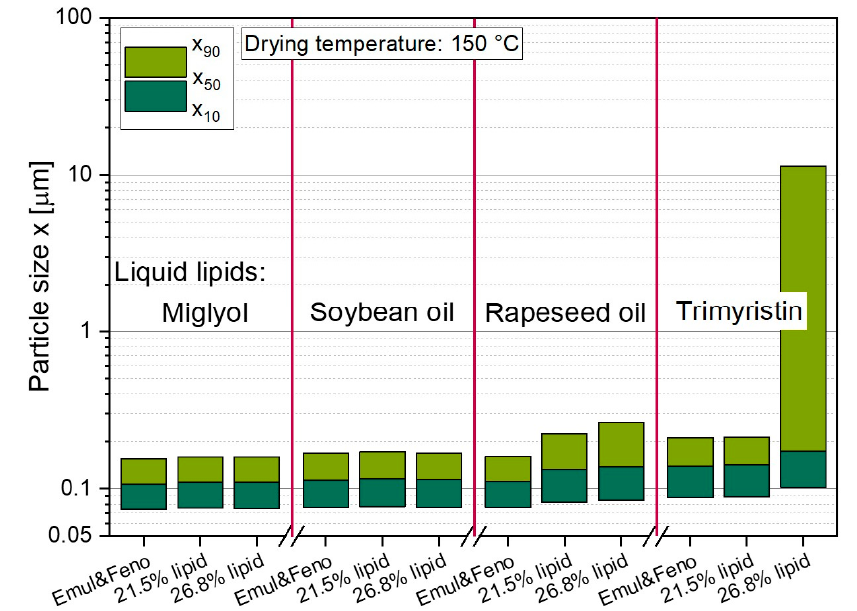
Figure 6. Particle sizes of lipid nanoemulsions loaded with FENO and of redispersed powders with lipid contents of 21.5 wt.% and 26.8 wt.%, respectively.